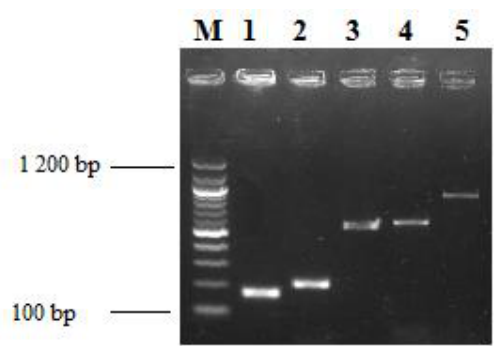
Figure 9. Gel electrophoresis of PCR product of Acinetobacter baumannii identification, virulence and resistance genes identified in this study. Each band represents the amplicon of one of the positive isolate for a given gene. M : 100 bp ladder; 1 : csuE (168 bp); 2 : ITS gene for Acinetobacter baumannii identification; 3 : bla CTX-M (550 bp); 4 : OmpA (578 bp); 5 : bla TEM (861 bp).